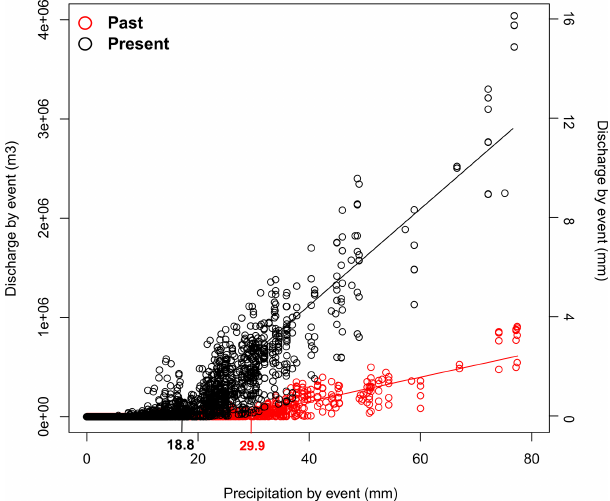
Figure 7. Relation between precipitation and discharge for all events in the 15-year period in the past (red points) and the present (black